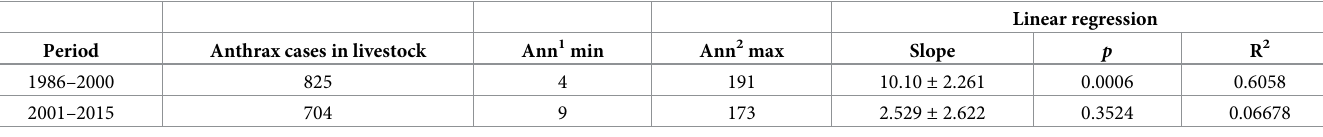
Table 1. Annual livestock anthrax incidences in Khuvsgul Province during (1986–2000) and after (2001–2015) the economic transition of Mongolia.